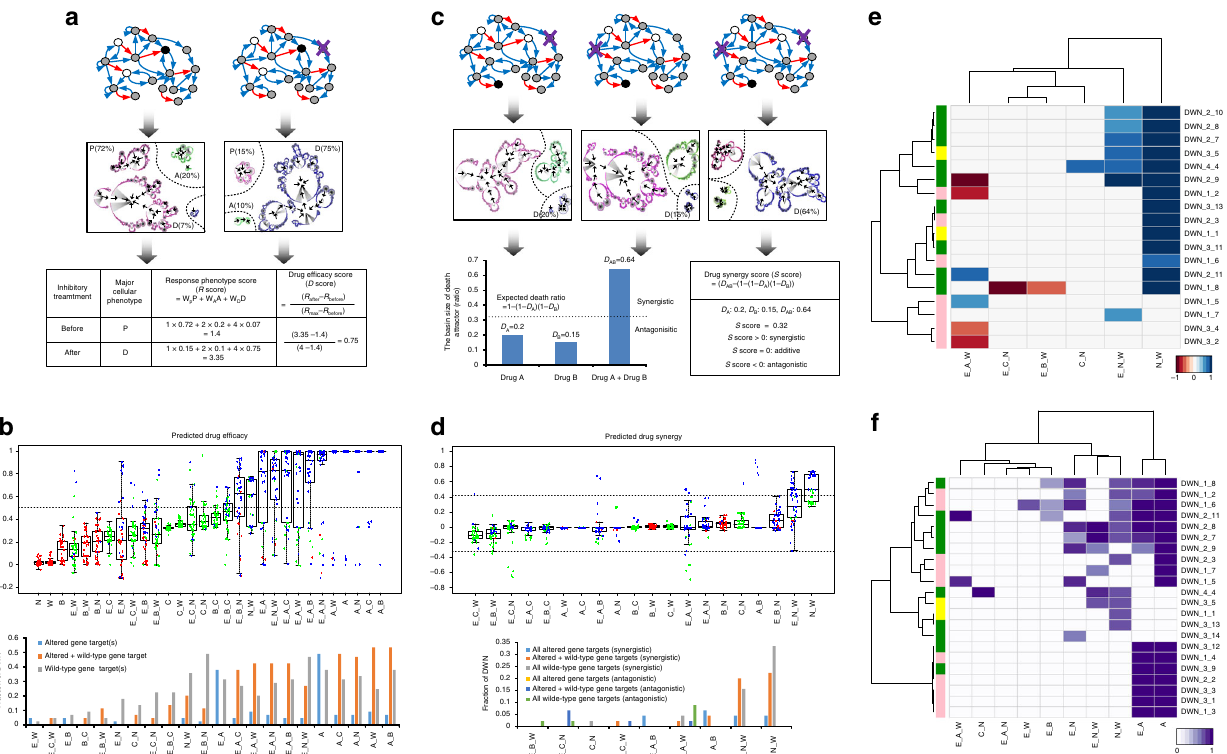
Fig. 4 Quantitative scores of differential cellular response to perturbations. a An example of the predicted drug ef fi cacy score. b (upper panel) Distribution of the predicted drug ef fi cacy ( D score). Each box plot shows the distribution of drug ef fi cacy scores of 45 distinct networks. The bold lines and the boxes represent the median and the interquartile range (25th and 75th percentiles) and the whiskers extended to 1.5 times the interquartile range. If D score > 0.5, we consider the corresponding drug is effective. Dot color denotes major cellular phenotype of each differentially wired network (DWN) in response to perturbation (red: P, green: A, blue: D). (lower panel) Distribution of the effective drug targets (i.e., high drug ef fi cacy, when death is the major cellular phenotype). Effective drug targets are divided into all altered gene target, combination of altered gene target, and wild-type gene target and all wild-type gene target. c An example of the predicted drug synergy score. Y -axis is the ratio of corresponding DWNs to total DWNs for the effective inhibitory treatment. d (upper panel) Distribution of the predicted drug synergy score ( S score). S scores are converted to z -scores to facilitate comparison and de fi nition of the synergistic (upper line)/antagonistic (bottom line) thresholds. Box plots show the median (the bold lines), the interquartile range (the boxes), and the lowest and highest scores within 1.5 times the interquartile range (the whiskers). Dot color denotes major cellular phenotype after perturbation (red: P, green: A, blue: D). (lower panel) Distribution of the selected synergistic/antagonistic drug combinations, consisting of altered gene target and wild-type gene target. Y -axis is the ratio of corresponding DWNs to total DWNs for the effective inhibitory treatment. e Selected synergistic or antagonistic drug pairs that comprise wild-type gene targets based on the drug synergy score. f Prediction of effective network-speci fi c drug target(s) that comprise wild-type gene